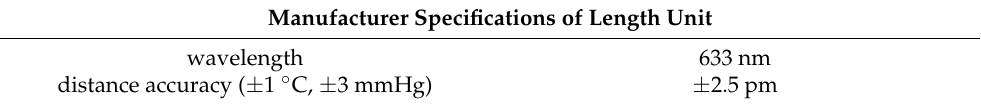
Table 1. The manufacturer specifications of length unit of laser tracker Leica LTD 840.